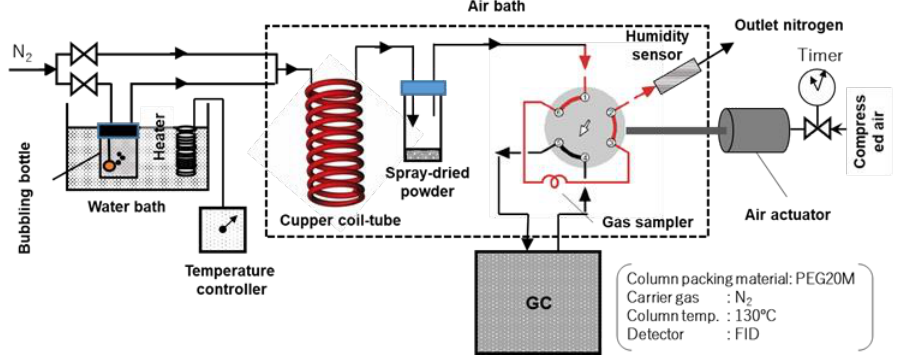
Figure 1. A home-built dynamic vapor sorption (DVS) instrument.